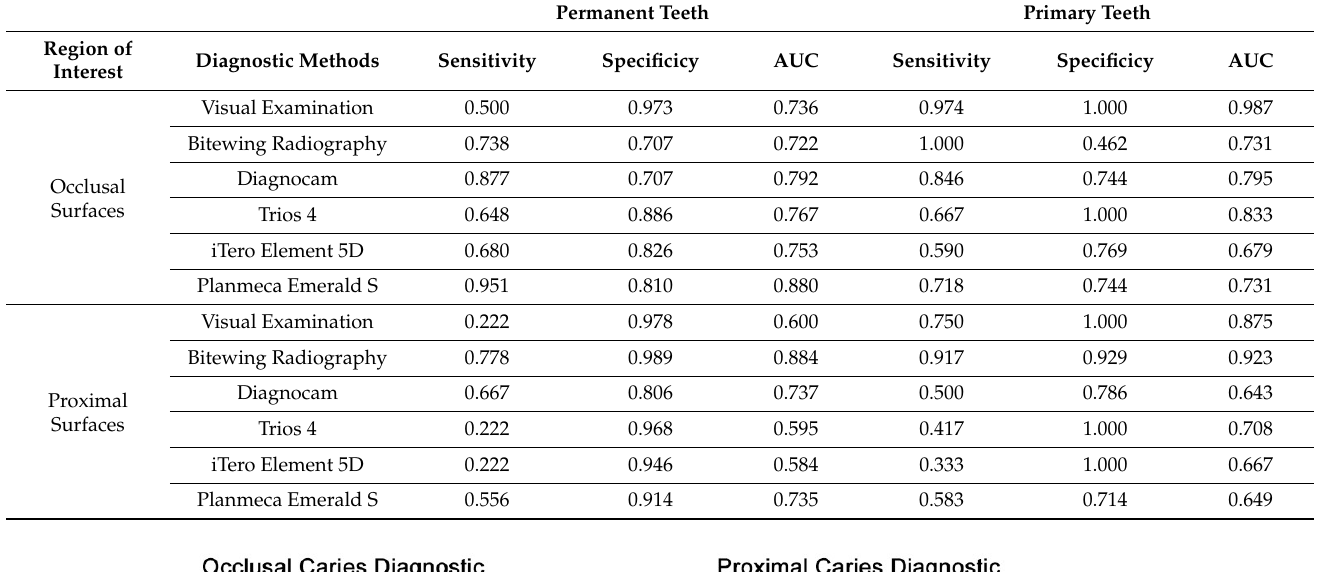
Table 2. Caries diagnostic methods regarding sensitivity, specificity, and area under curve (AUC) values with receiver operating characteristic (ROC) curve analysis for threshold II (sound/enamel caries versus dentin caries).